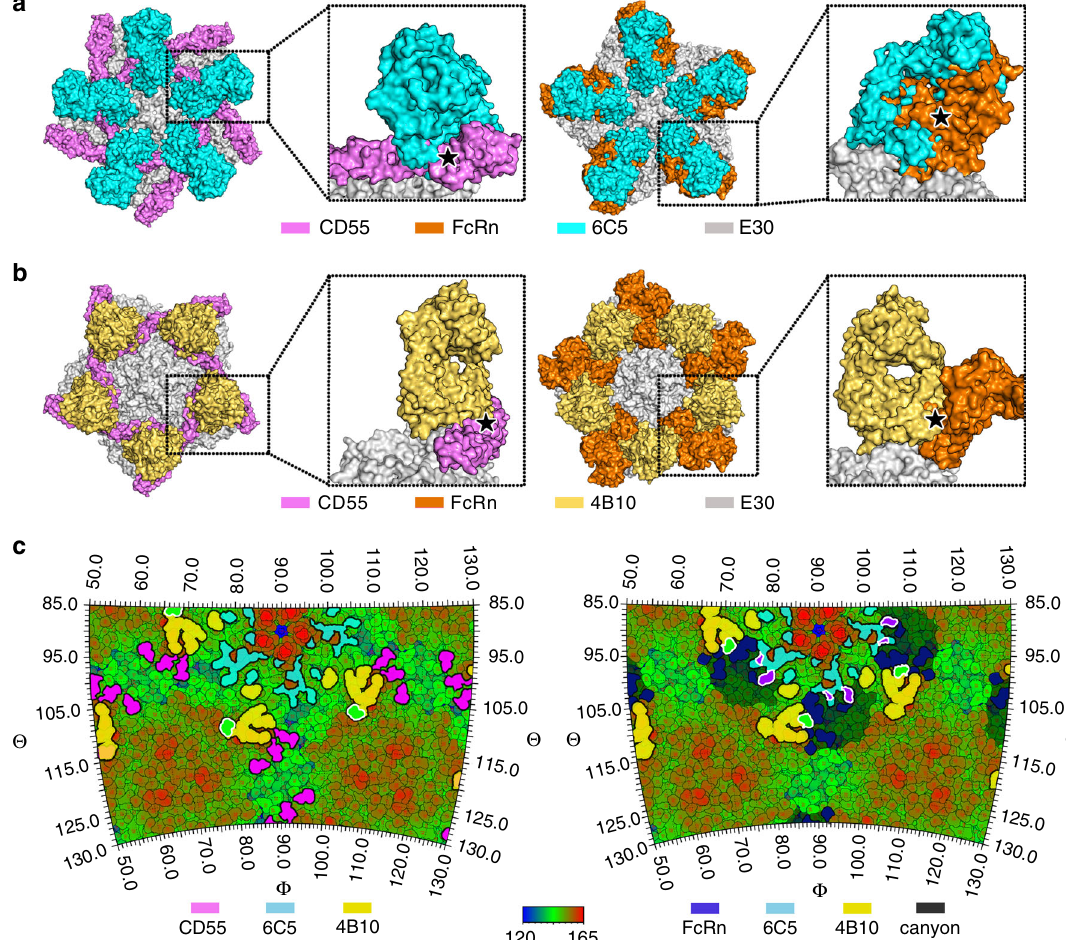
Fig. 5 Mechanism of neutralization of E30 by NAbs 6C5 and 4B10. a , b Clashes between Fab 6C5 (a)/4B10 (b) and E30 cellular receptors – CD55 (left)/ FcRn (right). The viral pentamer, Fabs 6C5 and 4B10, and receptors CD55 and FcRn are colored in grey, cyan, yellow, magenta, and orange, respectively. When E30-receptor-complex is superposed with E30-Fab-complex, clashes between each Fab and each receptor are prominent and marked with star symbols. c Roadmap exhibiting the footprints of FcRn, CD55, 6C5 and 4B10 on the viral surface. The footprints of CD55, 6C5 and 4B10 are colored in magenta, cyan, yellow, respectively in the left map, and the footprints of FcRn, 6C5 and 4B10 are colored in blue, cyan, yellow, respectively, in the right map, where canyons are shaded by light shadows. Overlapped footprints between receptors and 4B10 are colored in green and outlined with white lines, while the ones between receptors and 6C5 are colored in purple and outlined with white